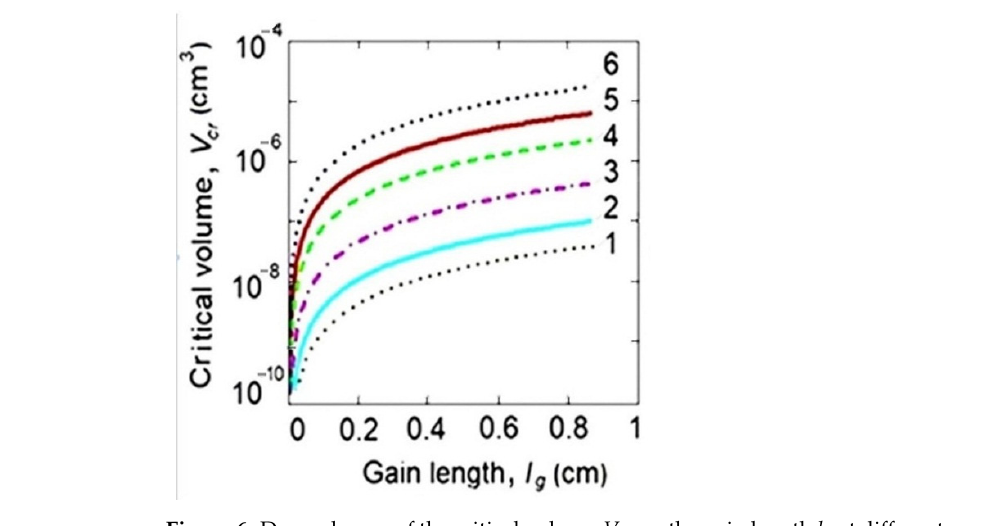
Figure 6. Dependences of the critical volume V cr on the gain length l g at different average randomized lengths l t , μ m: 1—0.387 (1 λ ); 2—0.74 (2 λ ); 3—1.94 (3 λ ); 4—5.85 (15 λ ); 5—11.6 (30 λ ); 6—15.5 (40 λ ).